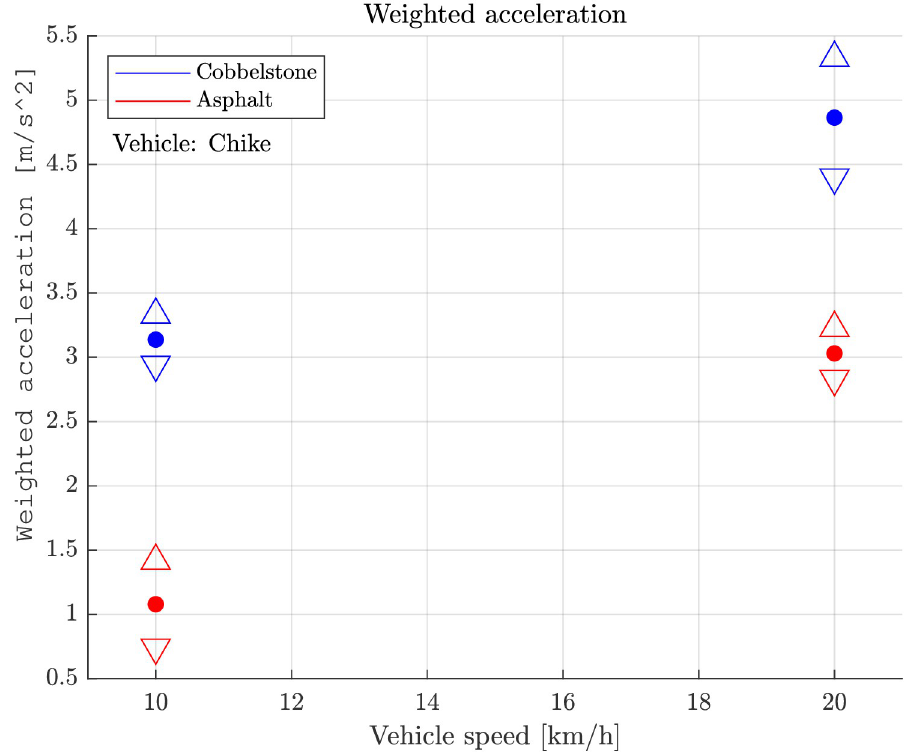
Fig 6. Cargo-Trike “Chike”: Weighted vibration level over vehicle speed on asphalt and cobblestones surface. 4 and 5 indicate the 95% confidence interval.